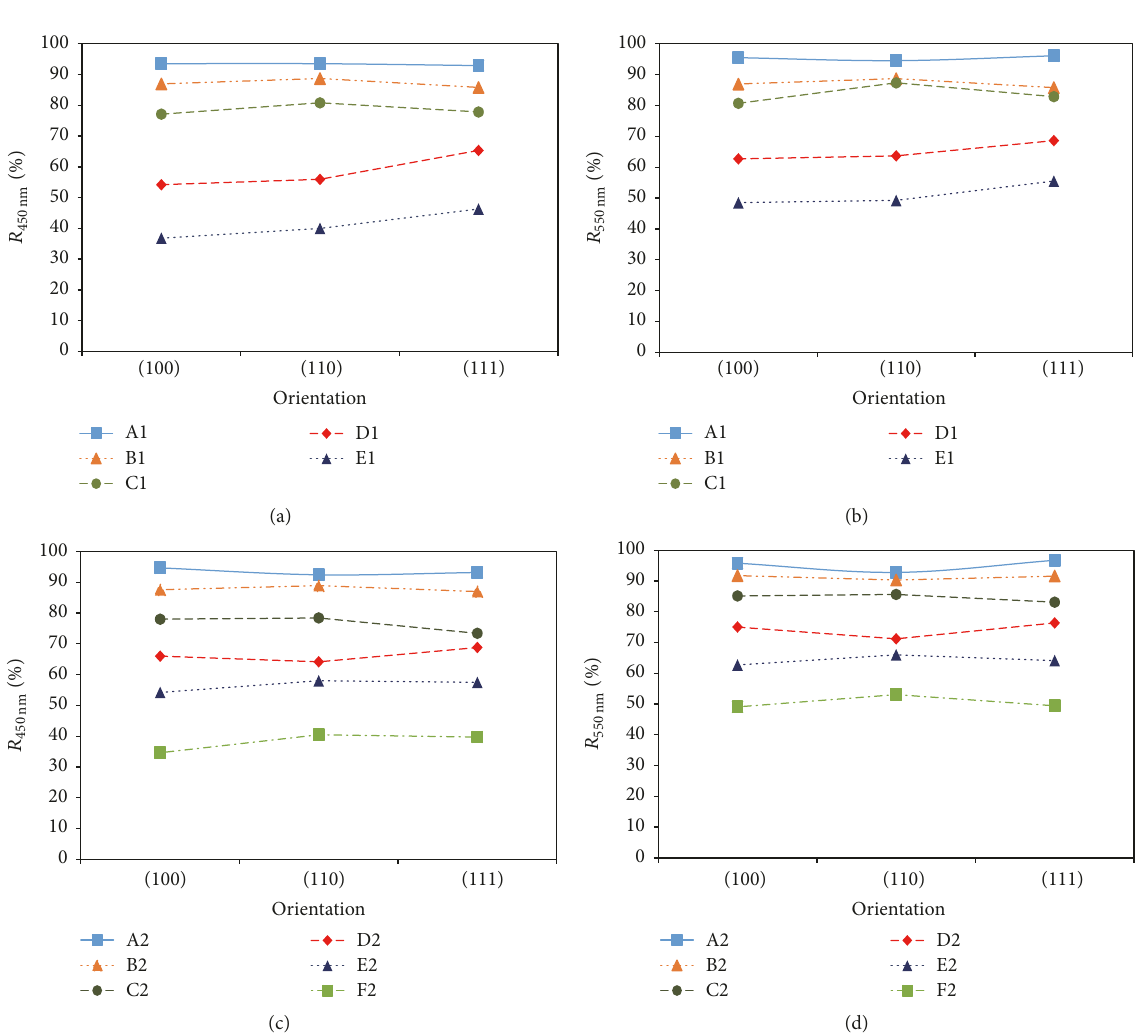
Figure 5: The effects of the Ag crystal orientations (100), (110), and (111) on the specular reflectance for different (a-b) 𝑅 𝑎 and (c-d) 𝑆 𝑑𝑟 groups at 𝜆 = 450nm and 550 nm, respectively. Table 2: Mean and one-way ANOVA of 𝑅 450 nm % and 𝑅 550 nm % among Groups A1–E1. Significance level 𝛼 = 0.05.